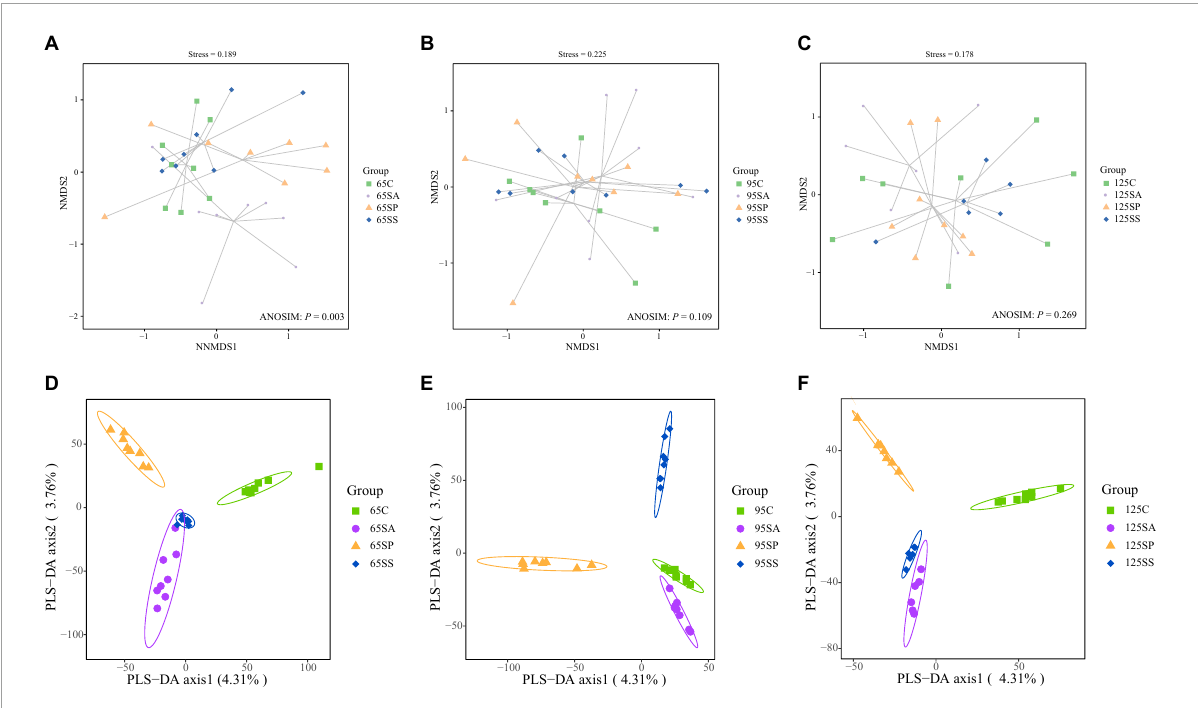
FIGURE1 Non-metric multidimensional scaling (NMDS) ordination plots based on the Bray-Curtis distance metric (A–C) and partial least square discriminant analysis (PLS-DA) plots (D–F) of the colonic microbiota community of offspring pigs at 65, 95, and 125 days of age. 65C, 95C, and 125C, sow fed with basal diet; 65SA, 95SA, and 125SA, sow fed with antibiotic; 65SP, 95SP, and 125SP, sow fed with probiotics; 65SS, 95SS, and 125SS, sow fed with synbiotics.